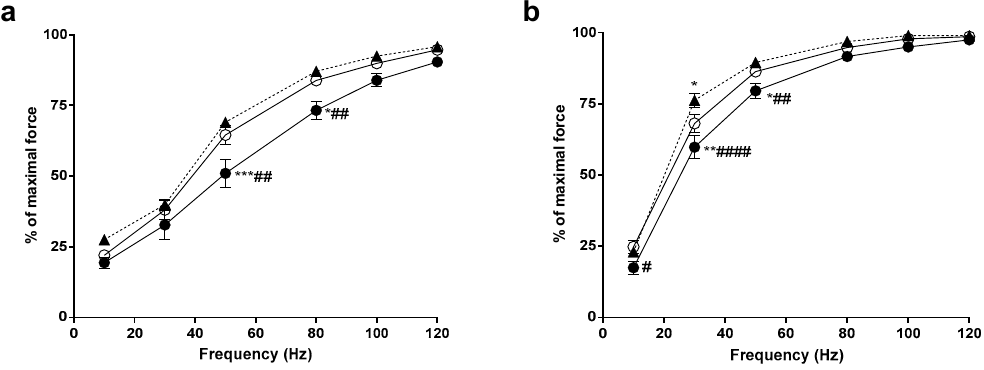
Figure 1. Force-frequency relationship of the extensor digitorum longus (EDL) and soleus (SOL) muscles. CON, open circles ( ); HIGH, closed triangles ( (cid:78) ); YEAR, closed circles ( (cid:8) ). ( a ) In the EDL, it was found that the force generated by the YEAR dose animals at 50 Hz and 80 Hz was significantly lower compared to both CON and HIGH animals; ( b ) in the SOL, the YEAR dose animals produced lower forces at 10 Hz, 30 Hz and 50 Hz compared to CON and HIGH animals. The force obtained by the HIGH animals at 30 Hz was significantly higher than the CON, however there were no di ff erences observed above 30Hz. Symbols indicate: * p < 0.05, ** p < 0.01, *** p < 0.001; di ff erent from